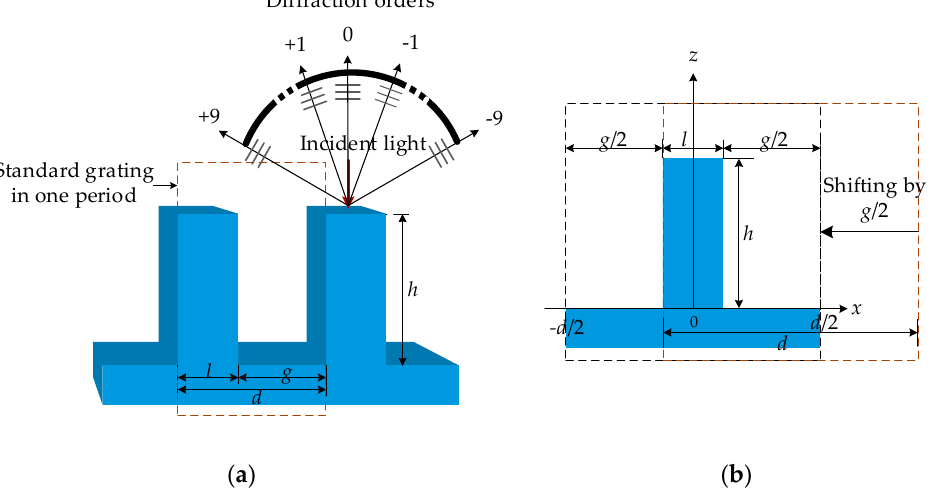
Figure 1. ( a ) The profile of a standard phase grating; ( b ) a cross-section in one period.